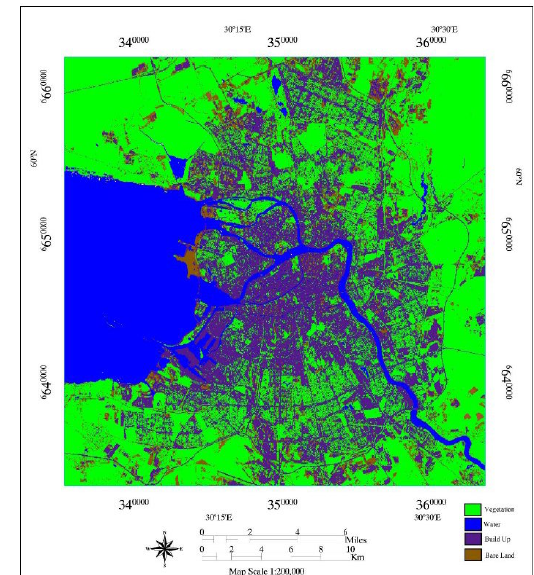
Figure 5. First-Level Classification results.